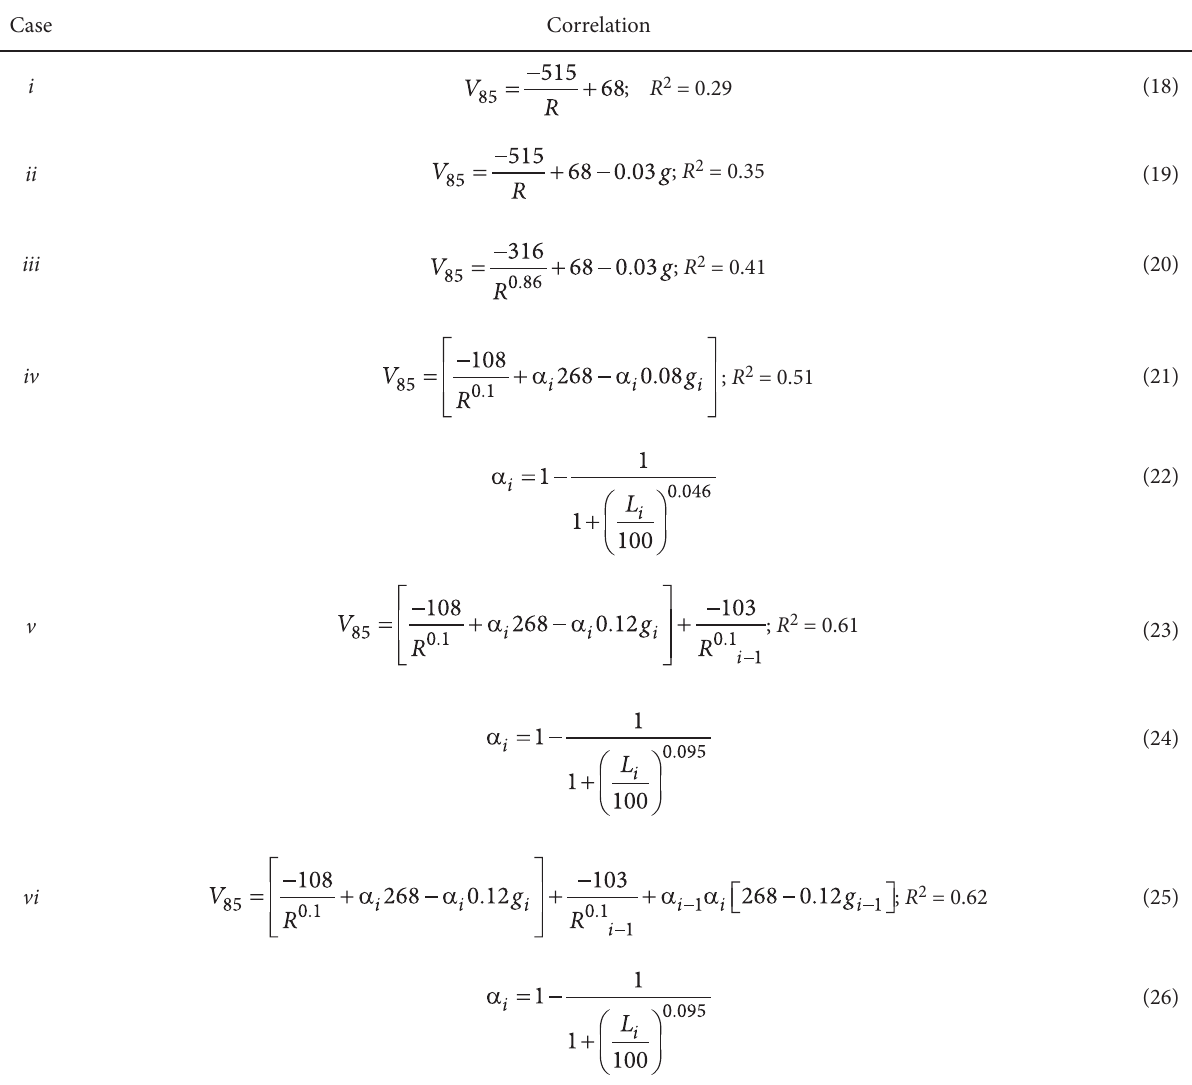
Table 4. Summary of models taken into account